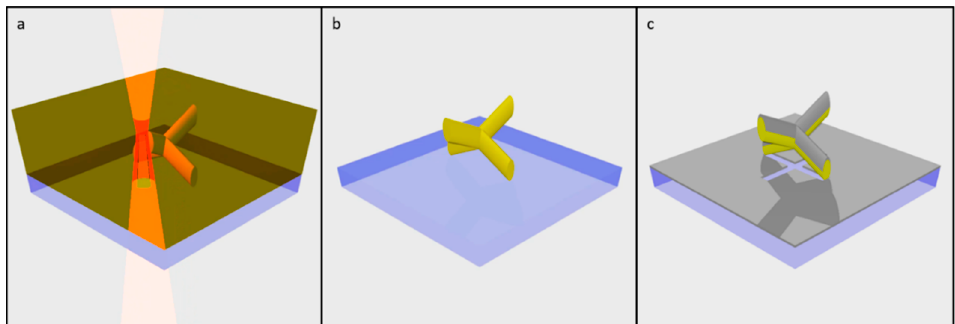
Figure 5. Illustration depicting the fabrication of a 3D arrangement of magnetic nanowires, via TPL and LOS deposition. ( a ) Exposure of photoresist during TPL; ( b ) Polymer scaffold after development of unexposed photoresist; ( c ) Resulting magnetic nanowires and sheet film, following deposition of a thin magnetic film.